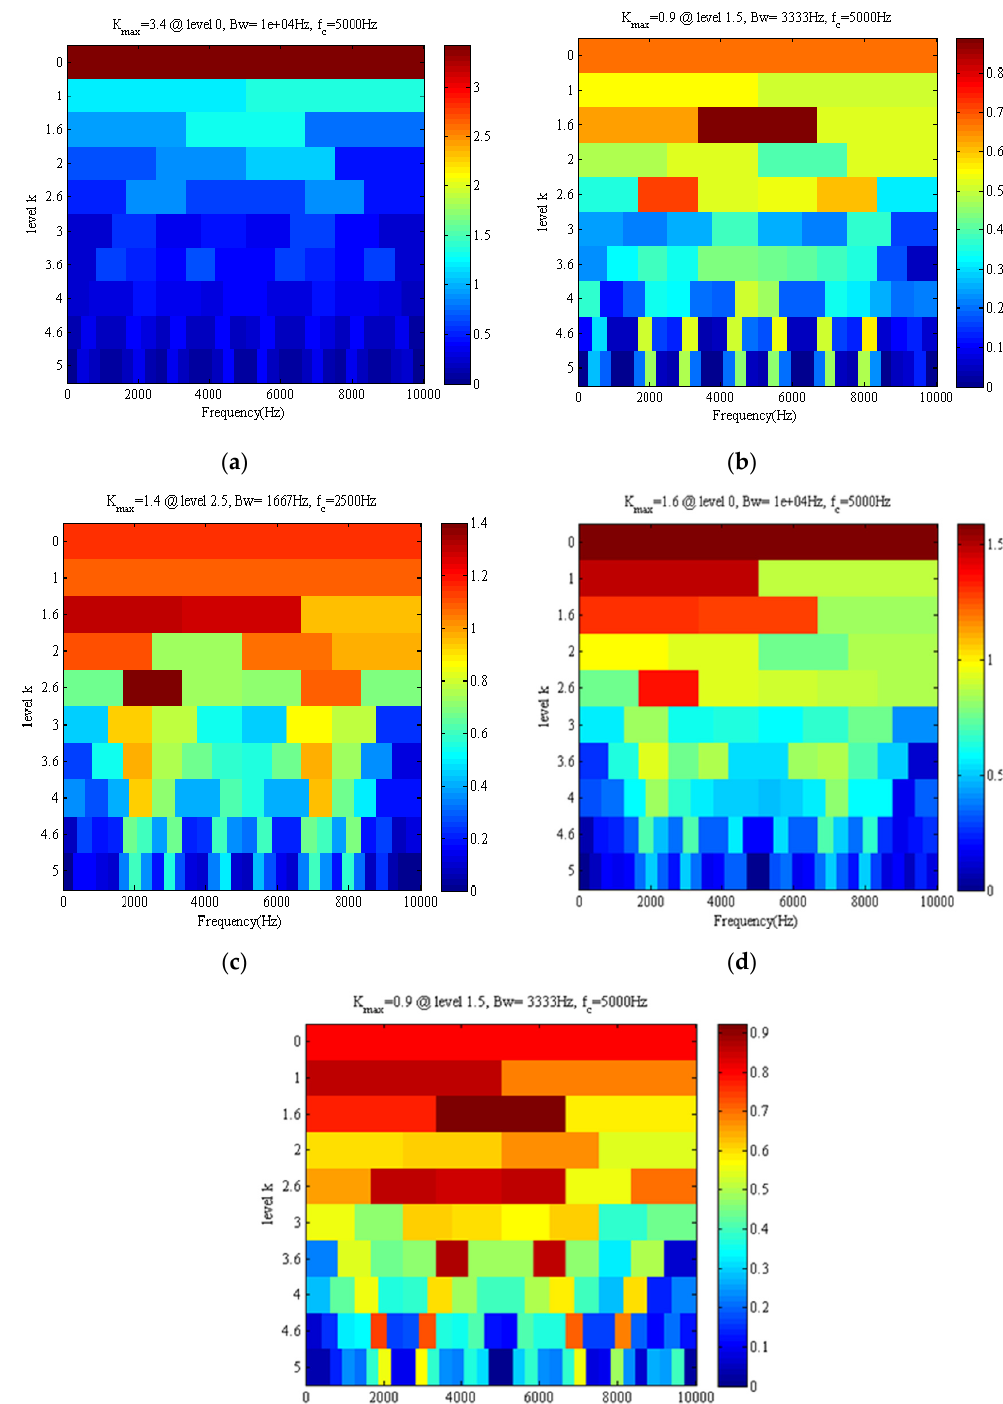
Figure 5. The results of the fast kurtogram (FK) ( a ) db1; ( b ) db2; ( c ) db3; ( d ) db4; ( e ) db5.